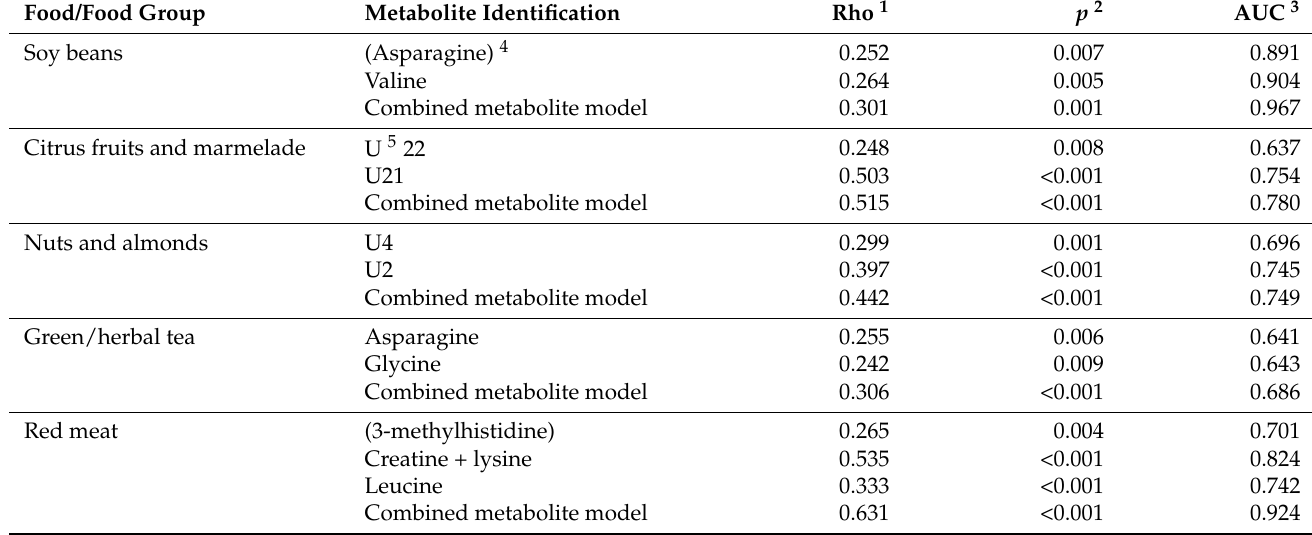
Table 2. Combined metabolite models to predict reported food intake among healthy Swedish subjects ( n =